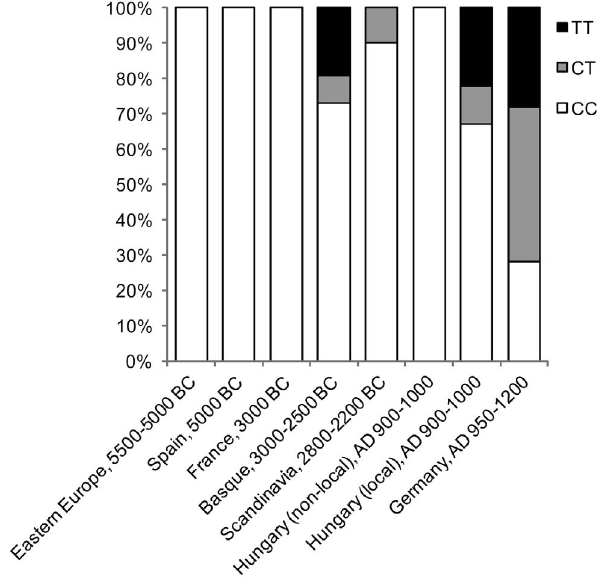
Figure 1. Relative frequency of lactase persistence and non- persistence genotypes reported in past European populations. CC: lactase non-persistent (wild type); CT and TT: lactase persistent. Study sample sizes and references are provided in Table 3. Data for Germany (AD 950–1200) are from this study.